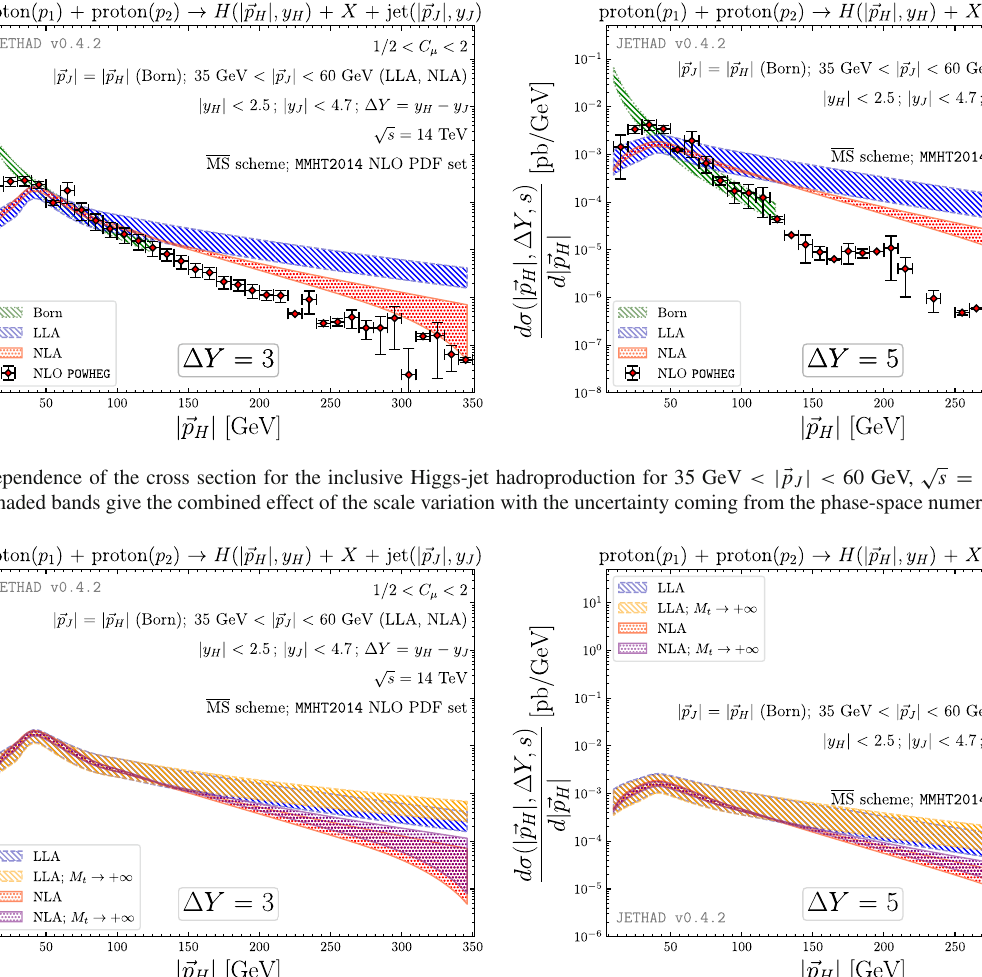
Fig. 9 p T -dependence of the cross section for the inclusive Higgs-jet Shaded bands give the combined effect of the scale variation with the hadroproduction in the standard case and in the large top-mass limit, uncertainty coming from the phase-space numerical √ s = 14 TeV and for (cid:6) Y = 3 , 5. for 35 GeV < | (cid:5) p J | < 60 GeV,